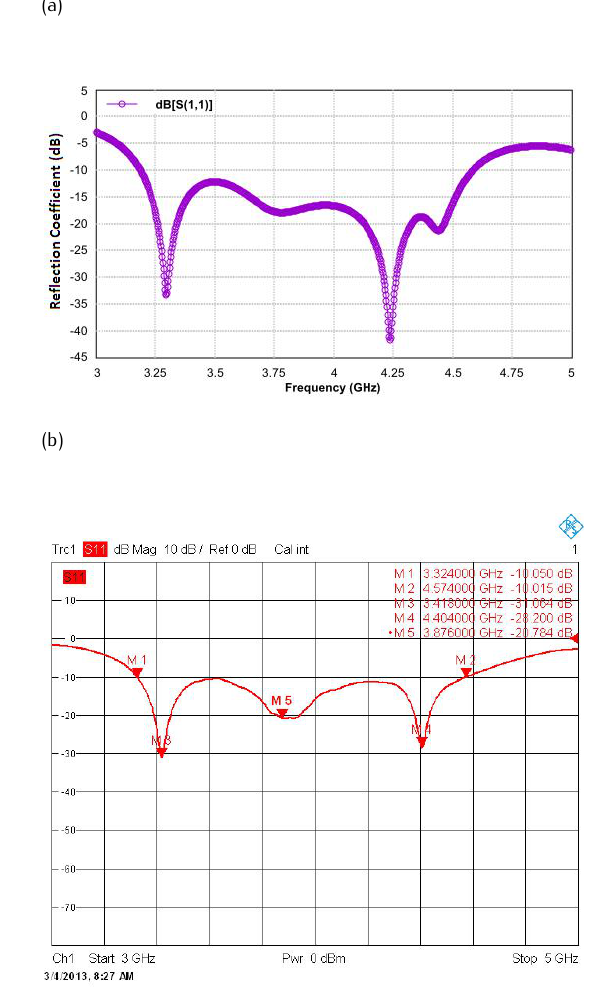
Figure 6. (a) Simulated reflection coefficient ( S 11 ) of stacked geometry with air gap h a = 1 . 59 mm and shorting pin; (b) Measured reflection coefficient ( S 11 ) of stacked geometry with air gap h a = 1 . 59 mm and shorting pin.